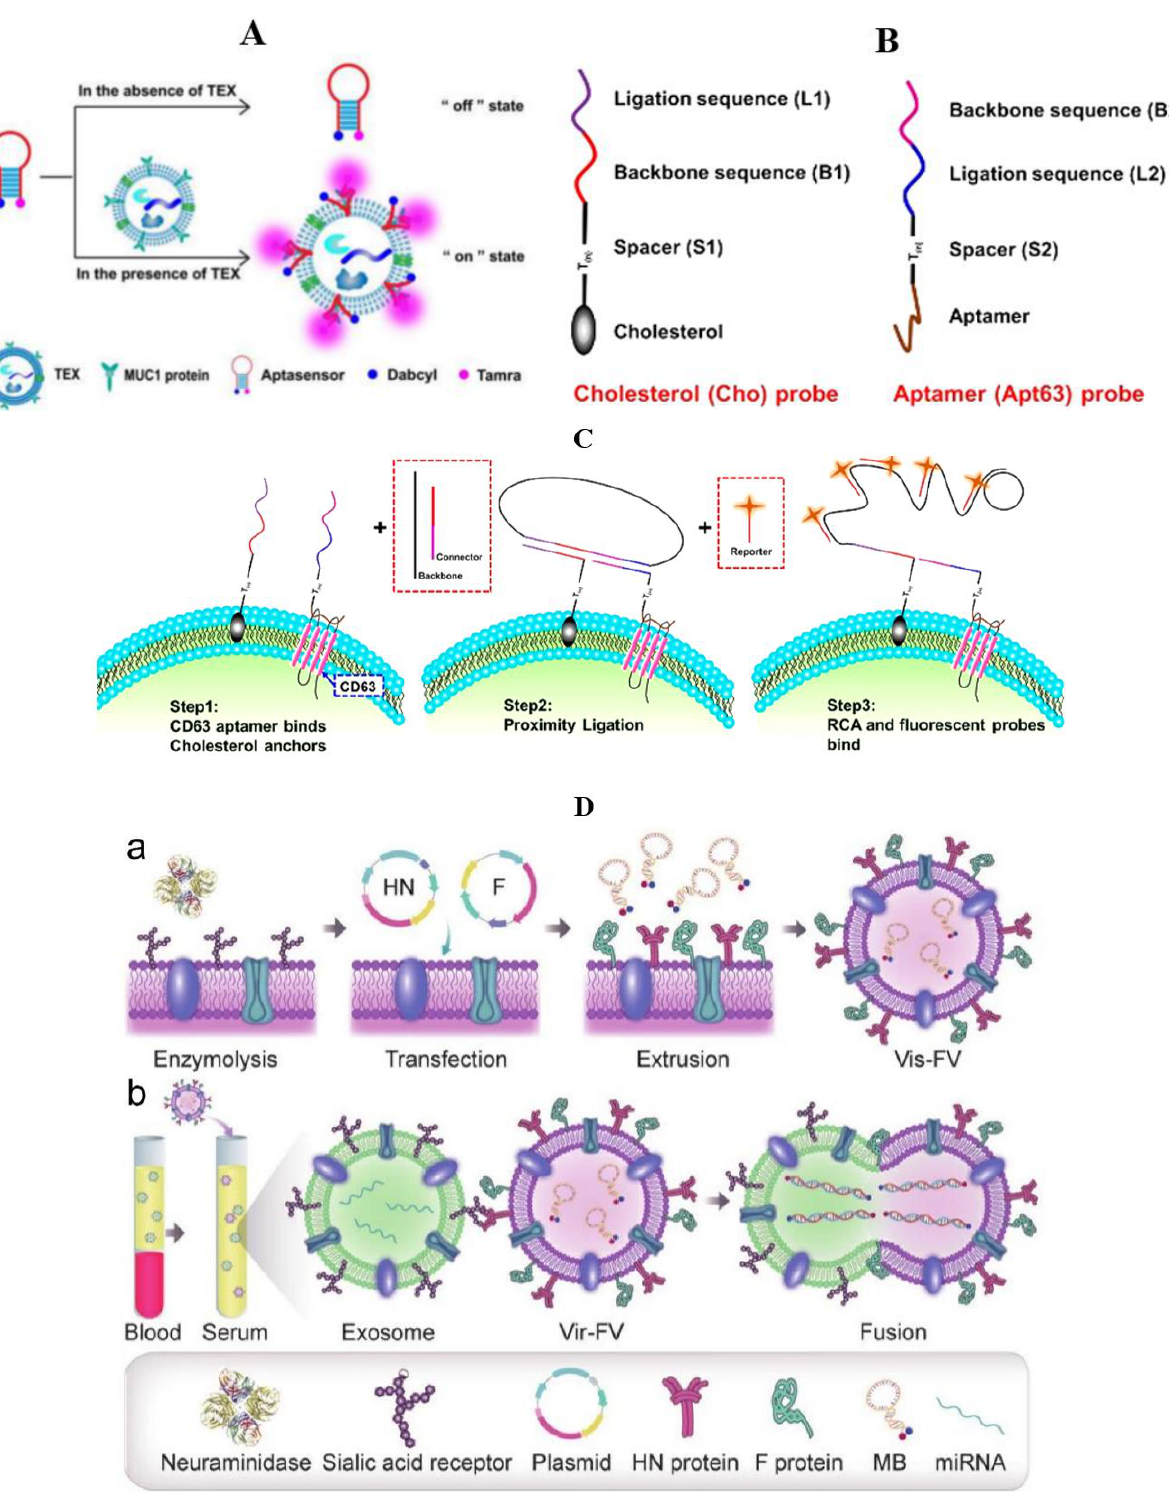
Figure 3. Detection of exosomes in breast cancer by the fluorescence method (nucleic acid aptamers). ( A ) Schematic illustration of the aptasensor for TEX detection [87]; ( B ) structure and functional domains of anti-CD63 aptamer probe and cholesterol probe [88]; ( C ) details of AcmPLA for target exosome recognition and signal amplification; CCS, cell culture supernatant [88]; ( D ) schematic illustration of the virus-mimicking fusogenic vesicles (Vir-FVs) for the rapid detection of exosomal miRNAs [92]: (a) preparation of the Vir-FVs. (b) The fusion between the Vir-FVs and exosomes caused by HN and F protein leads to the hybridization of the MB with the target